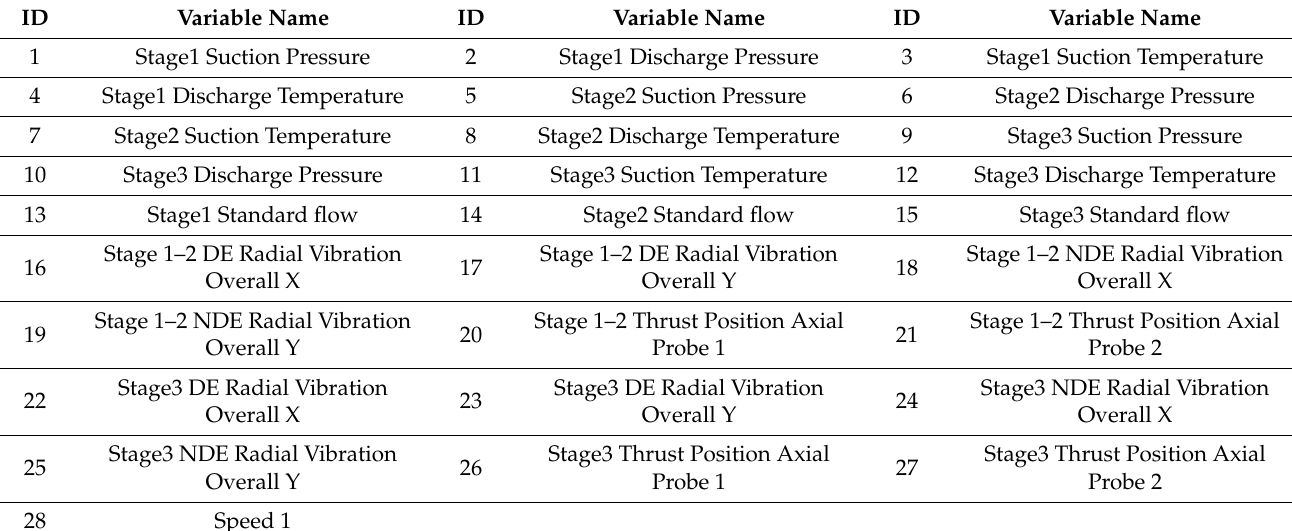
Table 5. Monitoring variables for a compressor system.